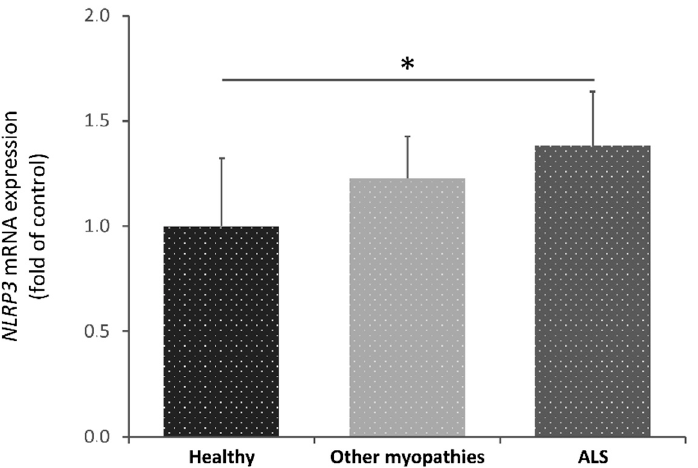
Figure 4. Transcriptional expression levels of NLRP3 in blood samples from healthy subjects (control), amyotrophic lateral sclerosis (ALS) patients and patients with other myopathies. Kruskal-Wallis tests showed significant differences among ALS patients and the healthy group ( p = 0.03). Dunnet’s post hoc test correction between groups also yielded statistically significant differences between these groups ( p = 0.04). A total of 42 participants were included in this study: 14 control individuals, 14 patients with other myopathies and 14 ALS patients * p <